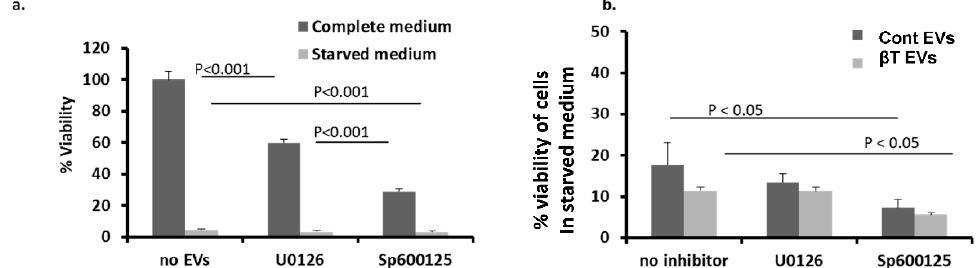
Figure 5. MAPK involvement in extracellular vesicle (EV)-induced viability of endothelial cells (ECs). ( a ) Human umbilical vein ECs were cultured in normal or starvation medium and incubated with or without MAPK inhibitors (U0126—MEK1/2 inhibitor and Sp600125—JNK1–3 inhibitor). ( b ) Starved ECs, cultured in medium without serum for 24 h with or without inhibitors, were stimulated with β T or control EVs (four samples for each group, in duplicates) and assessed by the XTT cell viability assay. The results are expressed as percentages of untreated (non-stimulated, non-starved) cells.